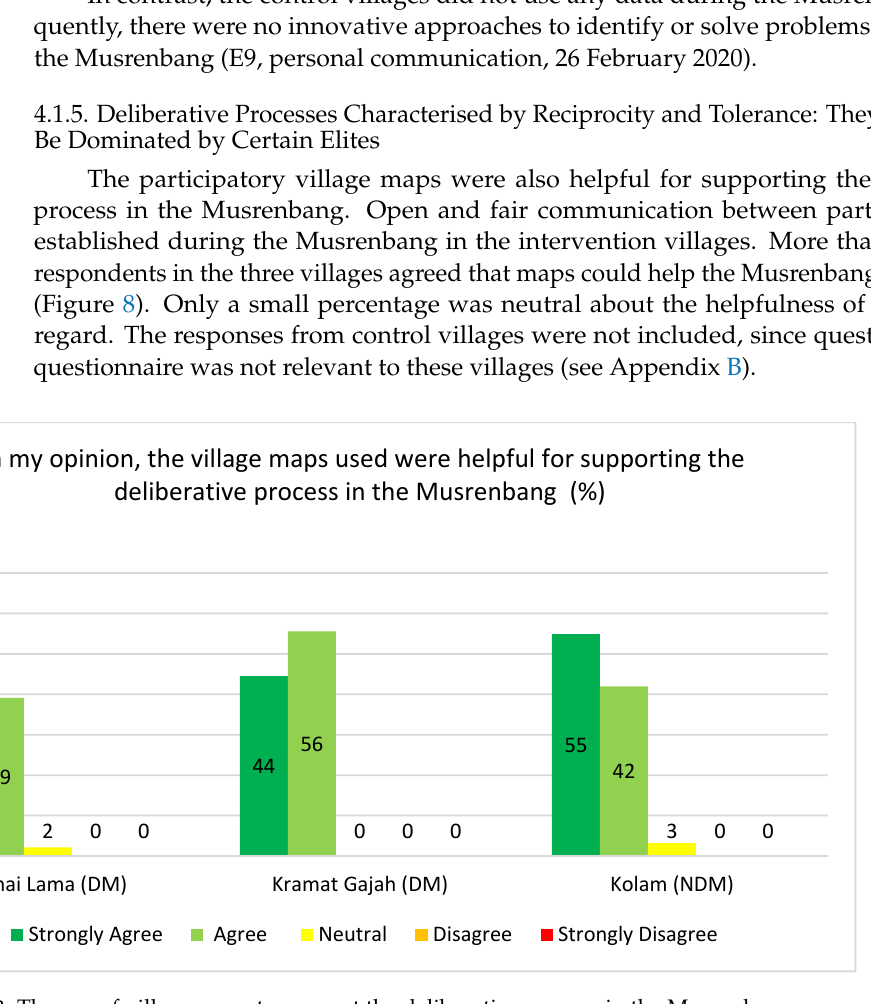
Figure 8. The use of village maps to support the deliberative process in the Musrenbang.